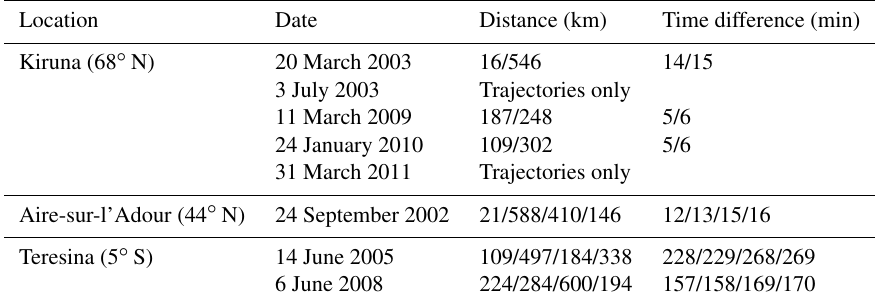
Figure 8. Average differences between MIPAS-E and MIPAS-B (Wetzel et al., 2018). The plots show the absolute (left) and relative (right) VMR mean differences between MIPAS-E and MIPAS-B (solid red line) for the match collocations found (red numbers). The standard deviation of the mean and standard deviation of the differences are represented by the error bars and the dotted red lines, respectively. The other curves displayed are systematic (dash-dotted blue lines), precision (dotted blue lines), and total combined errors (dashed blue lines) obtained by adding the errors in quadrature. Table 3. Overview of MIPAS-B flights used for intercomparison with